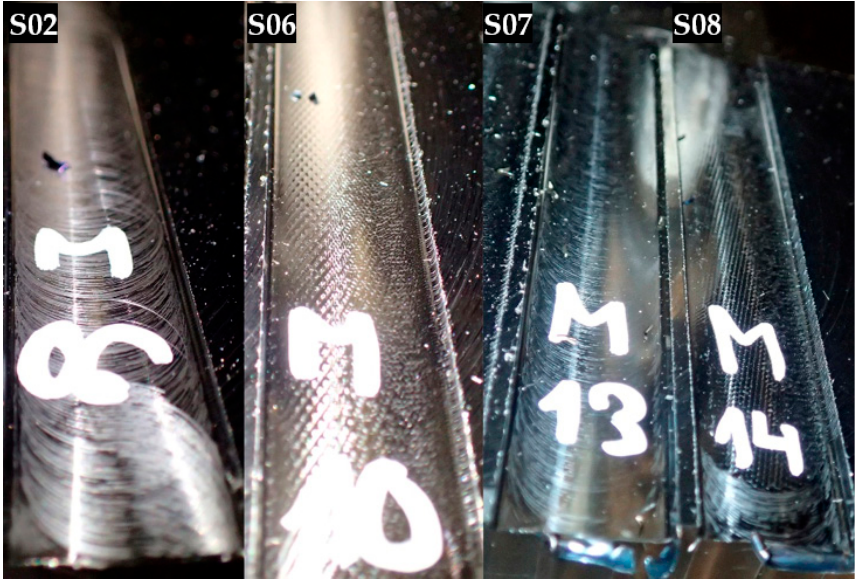
Figure 9. Surfaces from Experiments 1 and 2. The measurements S02 and S07 were identified as stable according to the surface, S06 and S08 as chatter.